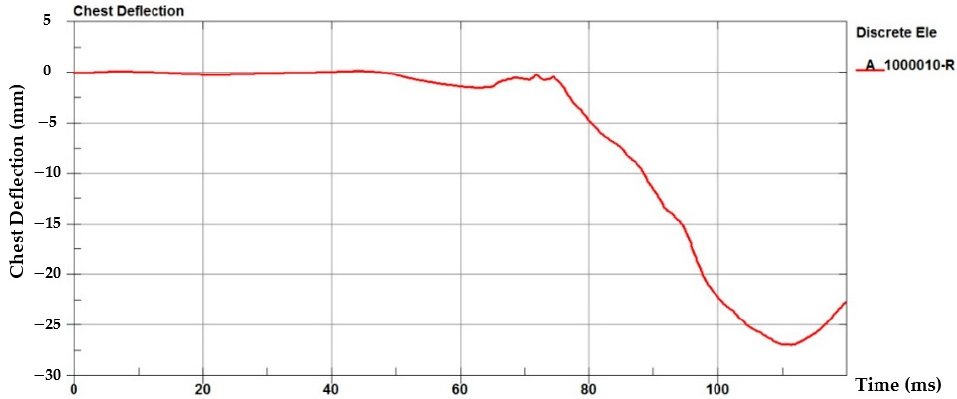
11 of 18 Figure 9. Acceleration and HIC 15 value of the dummy head: ( A ) Dummy head acceleration behav- ior; ( B ) Interval where the highest deceleration is present use to determine HIC parameter. The red line (A) in Figure 9 represents the head dummy behavior, and the blue line is the HIC 15 parameter, which has a value of 686.7 over interval t 1 = 91.84 and t 2 = 110.2. According to the data presented in the previous figure, the result is compared with the